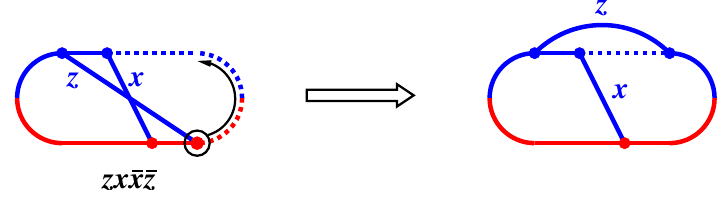
Figure 10 . The back-end transformation of the y ↔ z permutation of yx ¯ x ¯ y . The dotted lines indicate the soft gluon ( y → 0 ). The virtual diagram on the right is the same diagram as the yx ¯ xy diagram of figure 9 (since y is just a loop variable and not a fixed, external momentum fraction), but a different virtual gluon line is soft in the diagram